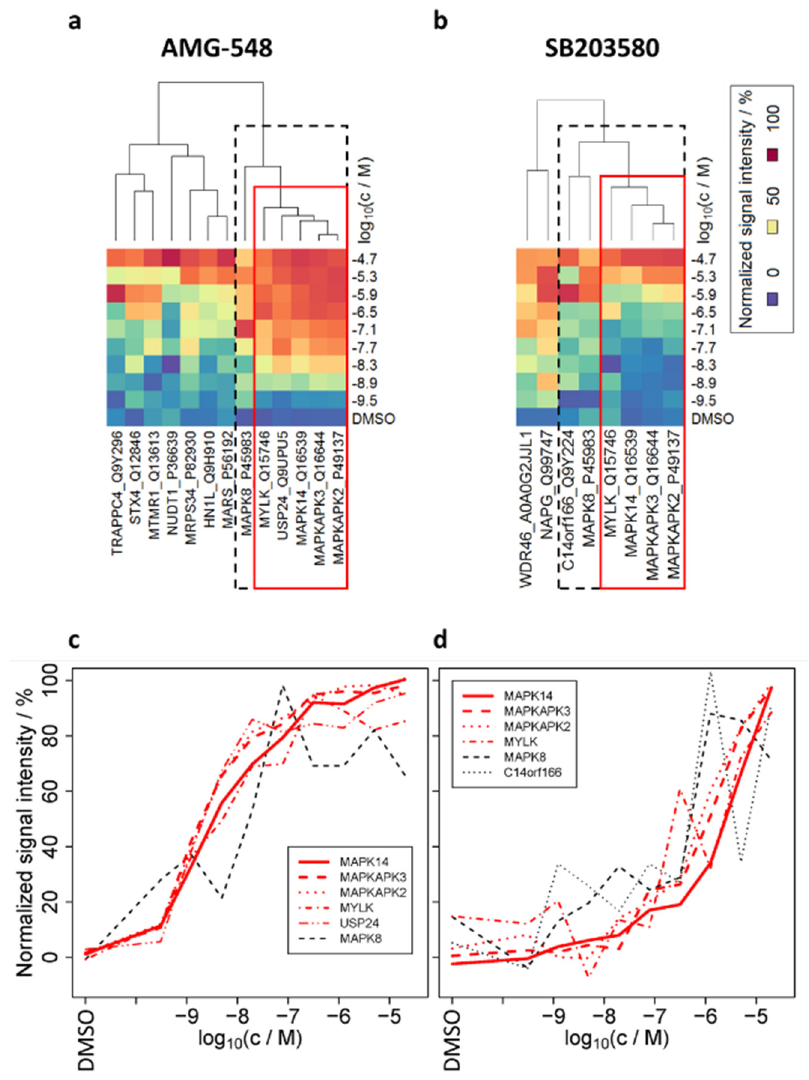
Figure 3. Heat maps after cluster analysis of the filtered (acceptable fit of dose–response curves for stabilized proteins, see experimental section for filter criteria) dose–responses (mean over replicates), derived from TPP-CCR experiments in living cells. ( a ) AMG-548, ( b ) SB203580. Narrower and wider clusters around the primary target MAPK14 are represented by red and dashed boxes, respectively. See Supplementary Figure S4 for the same representation for ERK 11e. Plots ( c , d ) show the normalized signal intensities of the proteins highlighted by the red and dashed boxes in ( a , b ), respectively, which are plotted in two dimensions instead of color-coded.